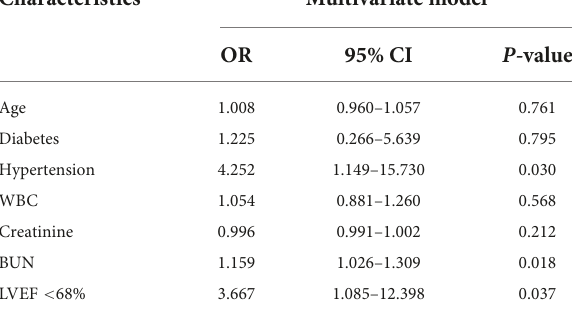
TABLE 2 Logistic regression analysis of AUGIB patients with myocardial injury.